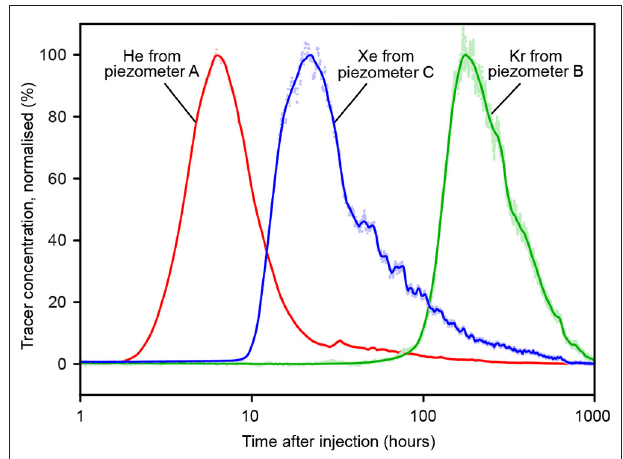
FIGURE 3 | Examples of breakthrough curves at the pumping well after injection of He, Kr, and Xe into the groundwater at piezometers A, B, and C using the bubble diffuser on 2021-09-07. Note the logarithmic scaling of the time axis.